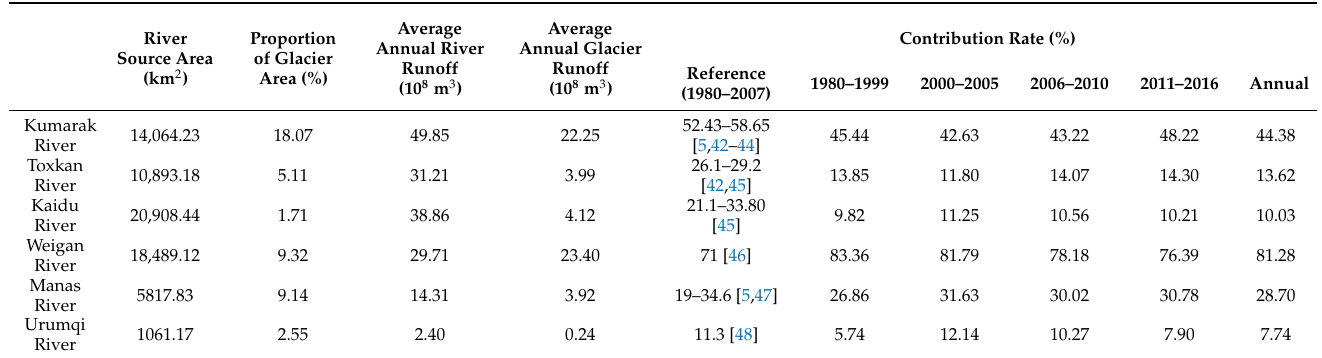
Table 3. Details of the six representative rivers and variations in the contribution of glacier runoff to river runoff in the Tien Shan Mountains of Central